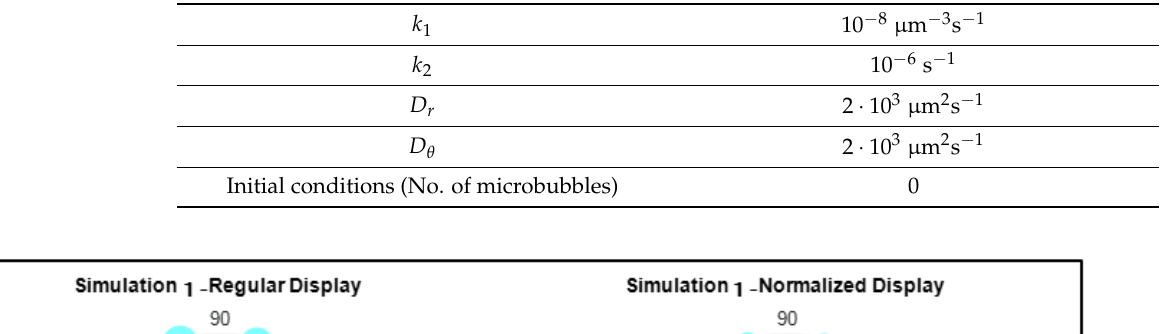
Table 3. Simulation 1: Constants and conditions.